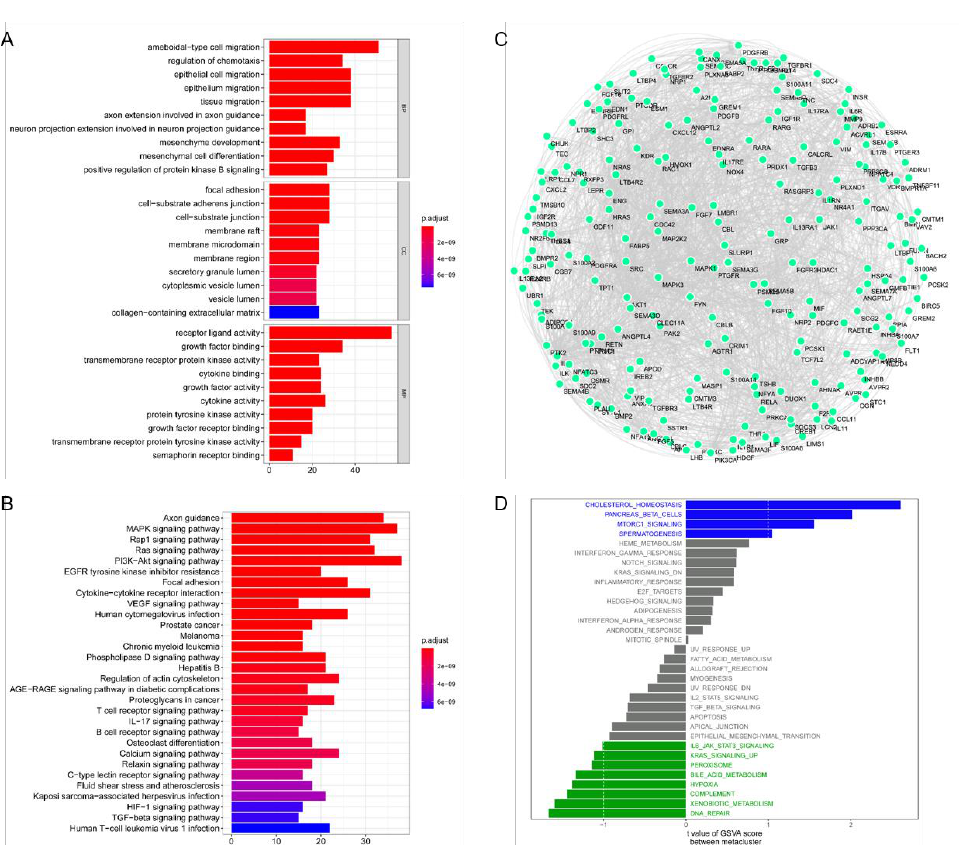
Figure 9. Functional analysis of key module genes. ( A ) Go enrichment analysis. ( B ) KEGG enrichment analysis. ( C ) PPI network analysis. ( D ) GSVA analysis.